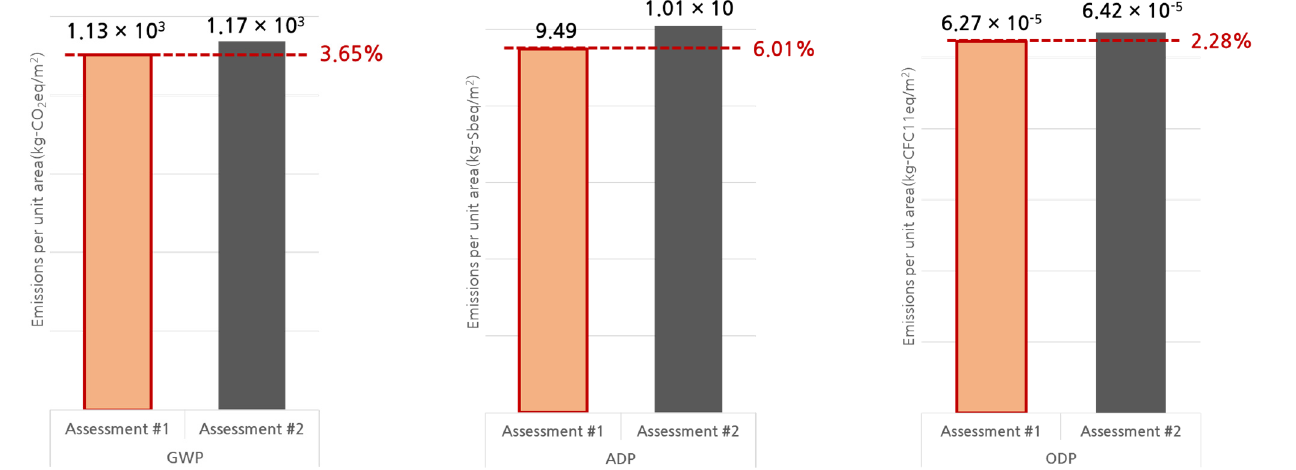
Figure 5. Comparison of the total life-cycle environmental impact of the apartment building.